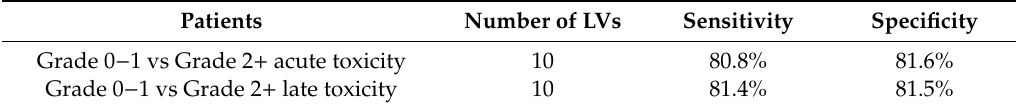
Table 3. Sensitivities and specificities for the PLS-DA classification of patients showing acute and late toxicity.